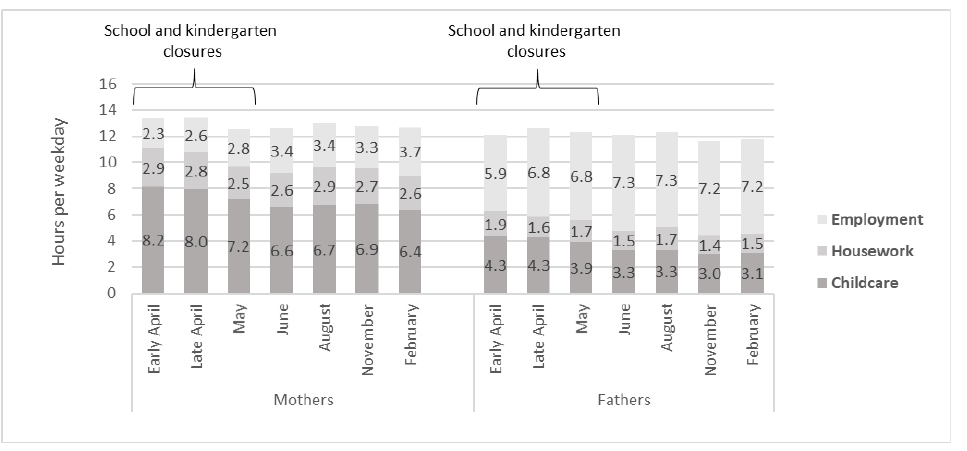
Figure 1 : Mean hours per weekday spent on childcare, housework, and